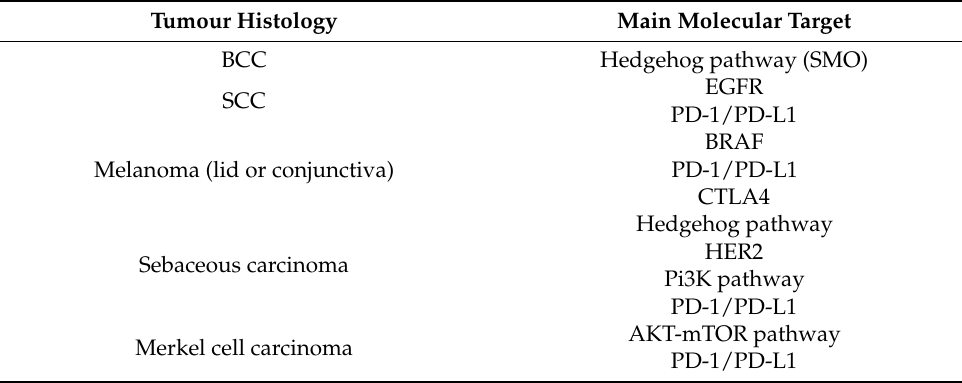
Table 2. Main targeted therapies and immunotherapies according to tumour